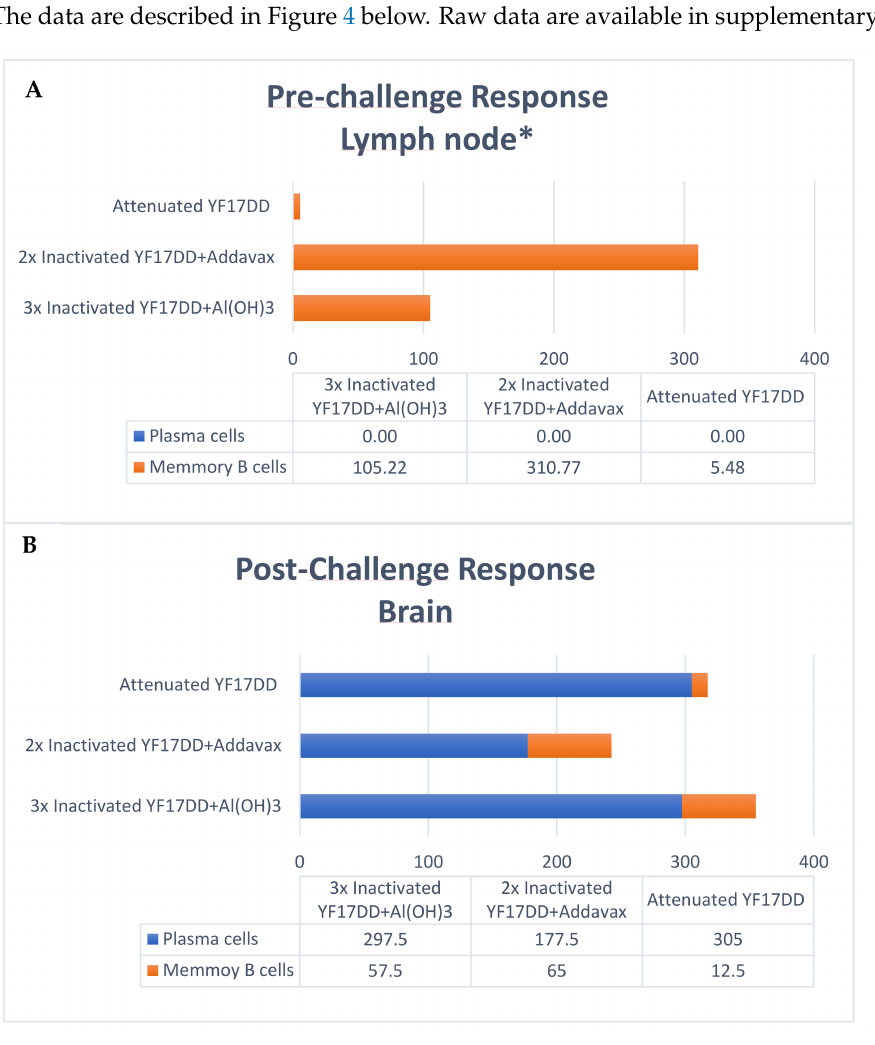
Figure 4. Analysis of the local response (draining lymph nodes and brain) by dosage of activated plasma cells and memory B cells by IgG ELISpot at pre-challenge ( A ) and post-challenge ( B ) times. Data expressed in SFCs/10 6 . Samples of brain dosed in pool per group. * Dosage of activated plasma cells not performed due to lack of sufficient available lymph node